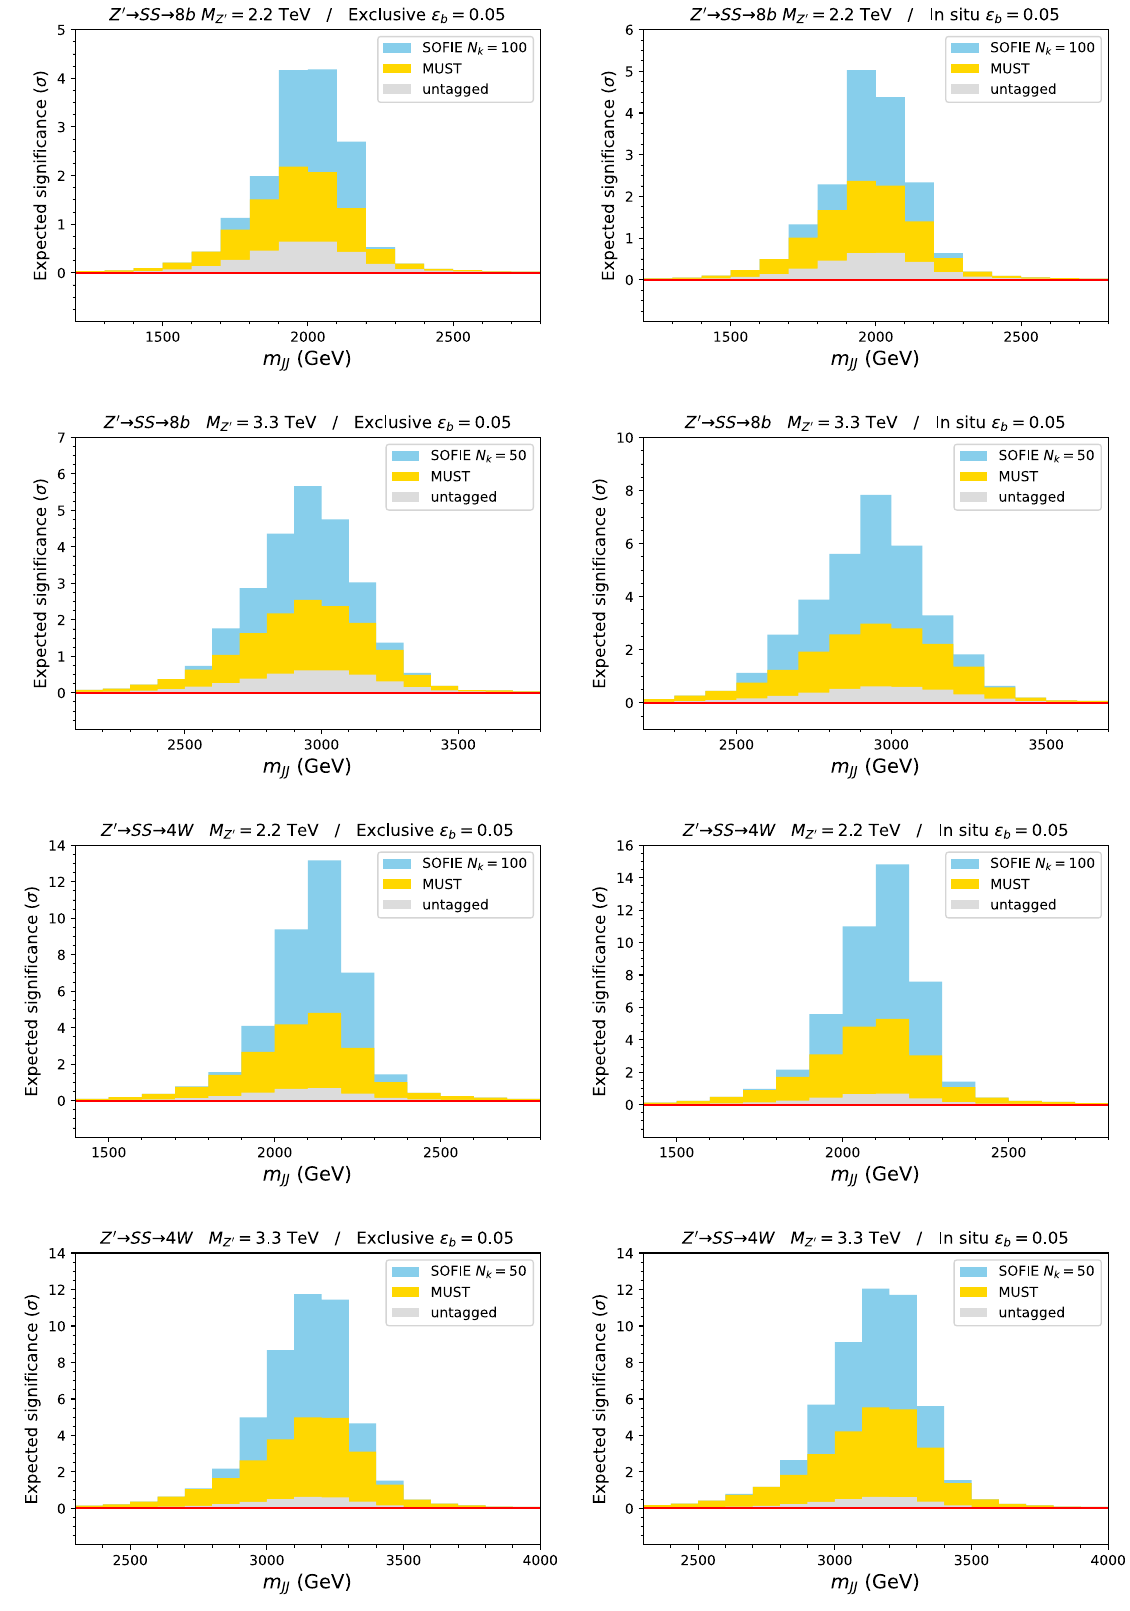
Fig. 11 Expected significance of the deviations per 100 GeV bin at three stages: a in the untagged event sample; b using only the MUST jet tagging; c using the full SOFIE anomaly detection method. Exclusive (left column) and in-situ (right column) mass decorrelation is used with ε = 0 . 05 b